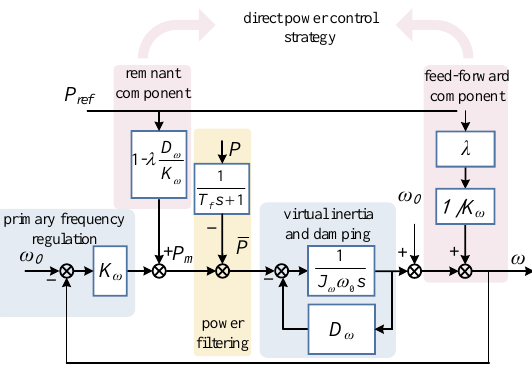
Figure 6. Control block diagram of direct power control strategy based on VVSG.